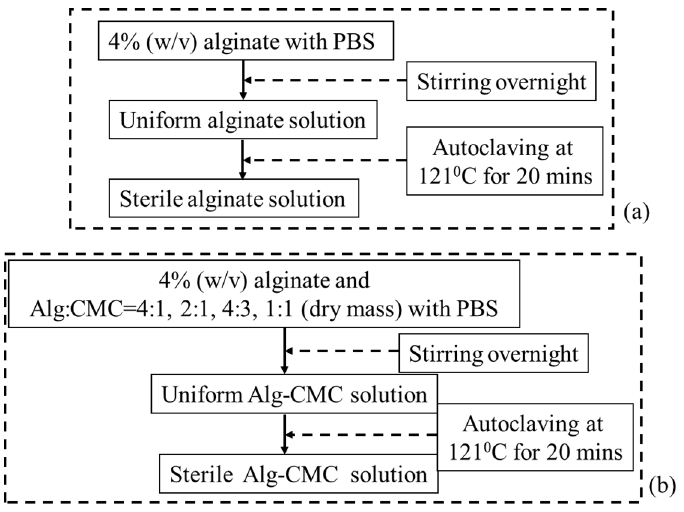
Figure 2. Preparation of ( a ) Alginate and ( b ) Alginate-CMC.